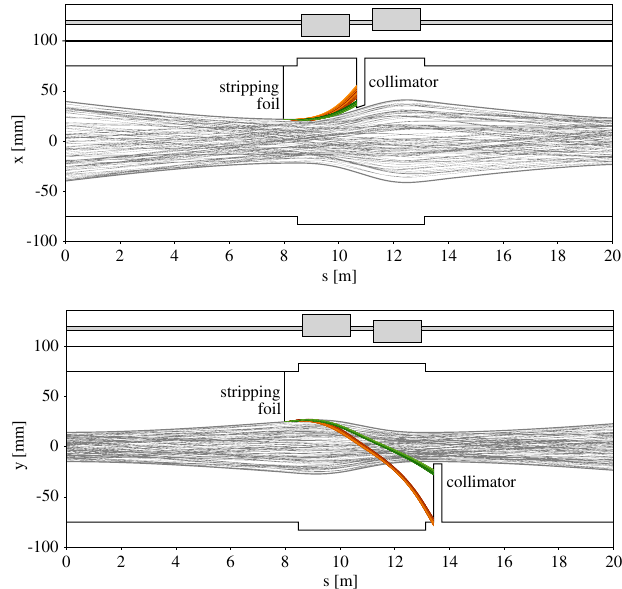
FIG. 13. Tracks of the 238 U 92 þ (orange) and 84 Kr 36 þ (green) ions deflected in the horizontal (above) and vertical (below) plane by the quadrupole field. The initial primary ions of charge states 238 U 28 þ and 84 Kr 17 þ were stripped by using the 500 μ m thick titanium foil.